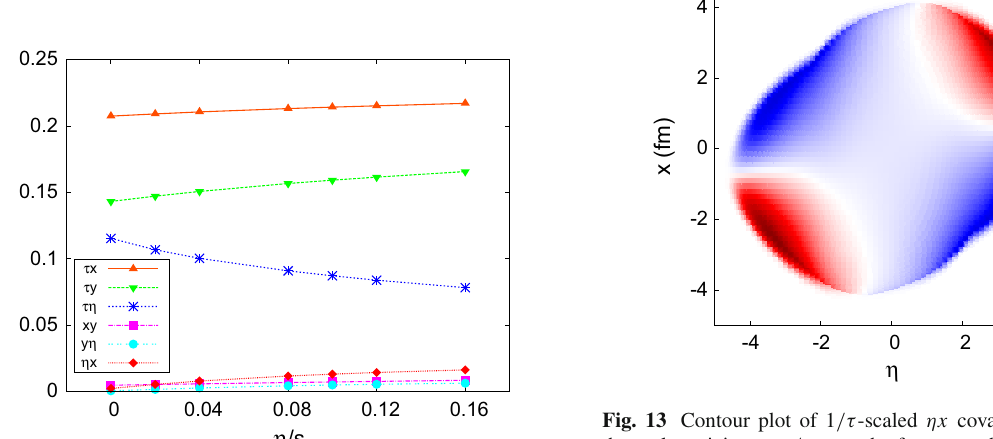
Fig. 10 Estimatedangularmomentum(in ¯ h units)oftheoverlapregion of the two colliding nuclei (solid line) and total angular momentum of the plasma according to the parametrization of the initial conditions (dashed line), as a function of the impact parameter